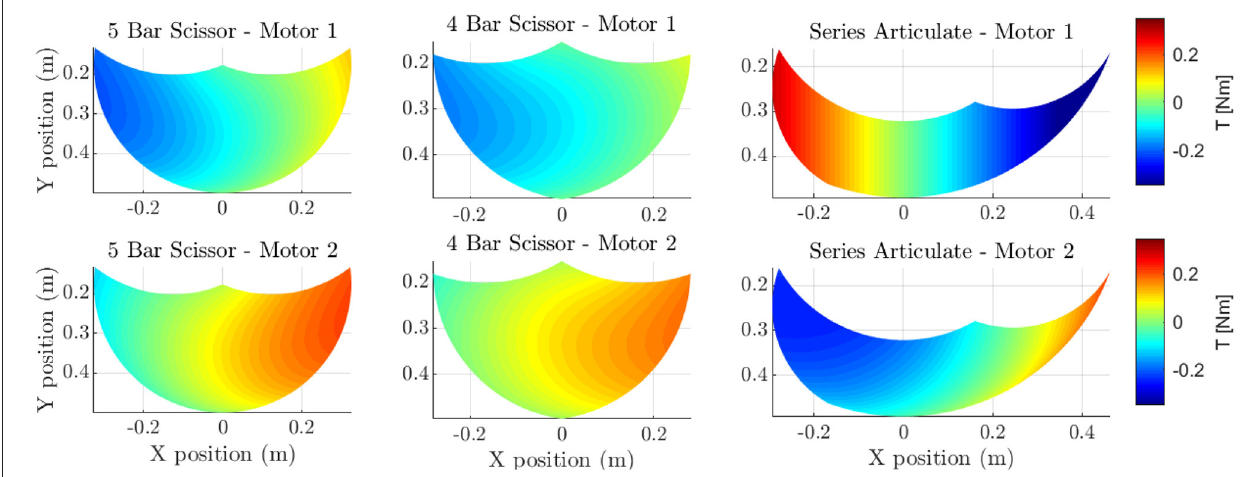
FIGURE 1 | The load distribution characteristics of each linkage are shown. The four-bar and five-bar scissor linkages are seen to have a good load distribution for a 1 N vertical force at the foot. However, the series articulate can be seen to have higher requirements from each motor, overall requiring higher rated torque motor to generate the 1 N force. This figure also roughly depicts the shape of each linkages